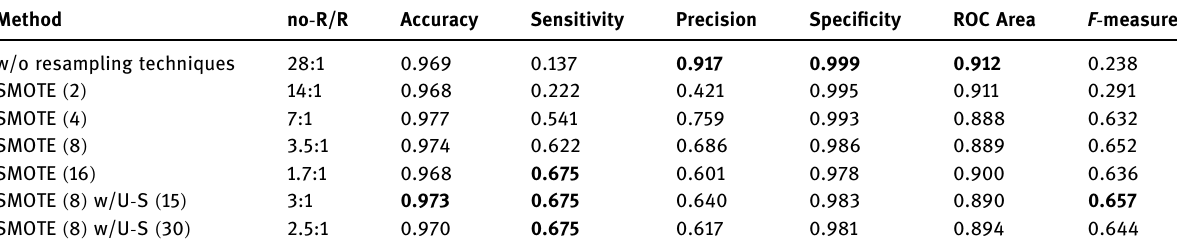
Table 5: Applying AdaBoost with resampling techniques Method w/o resampling techniques